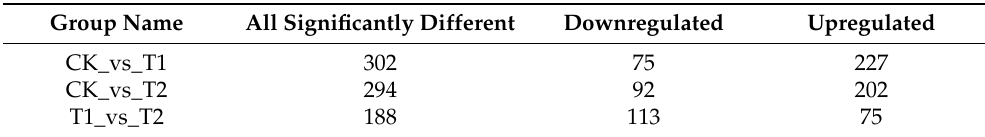
Table 1. Statistics of differentially abundant metabolites.